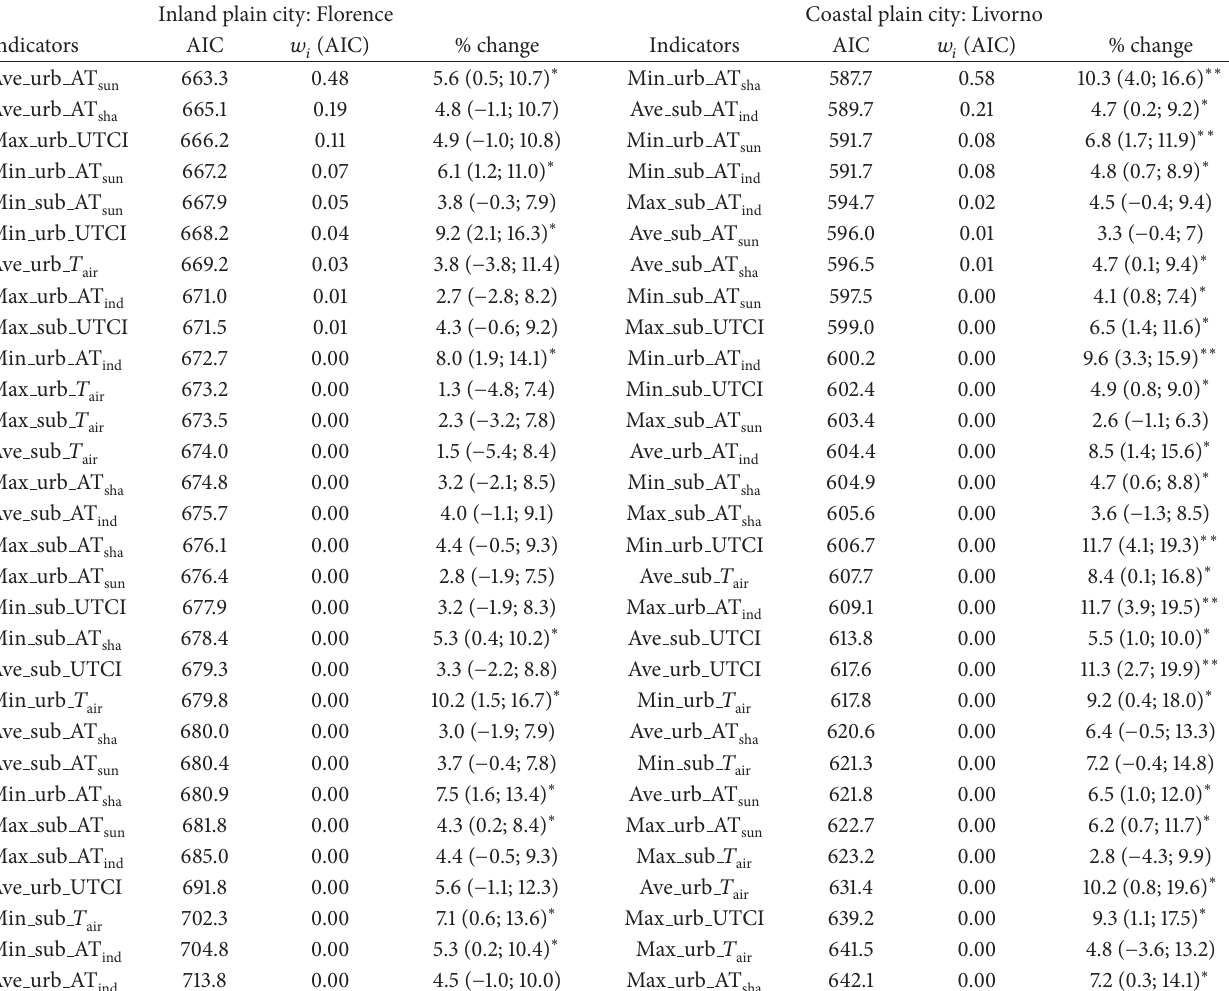
Table 4: Summary of predictive model fits and expected % change in deaths due to a 1 ∘ C increase in the thermal predictor over the 75th percentile based on each thermal indicator. ∗ 𝑃 < 0.05 ; ∗∗ 𝑃 < 0.01